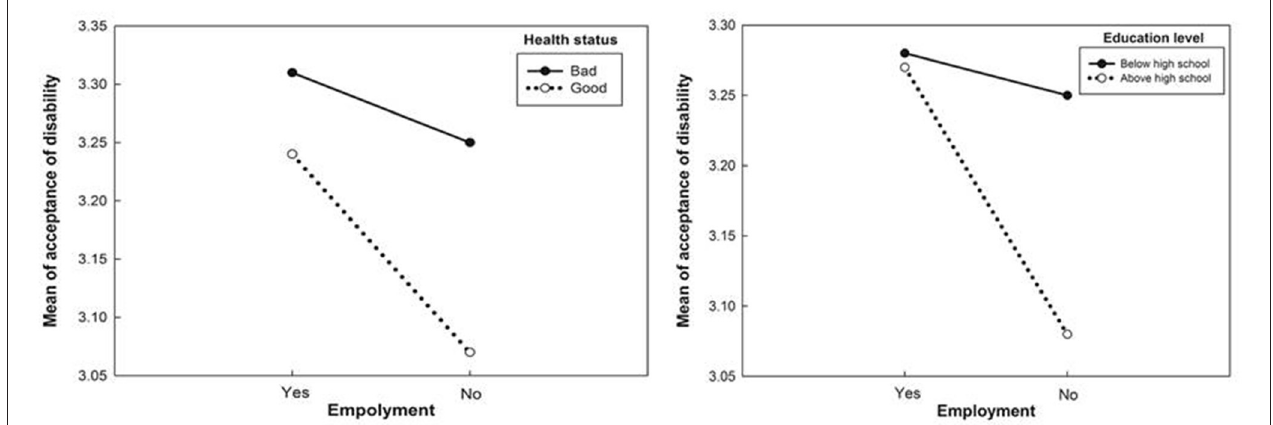
FIGURE 1 | Employment effects of health status and educational level on acceptance of disability.